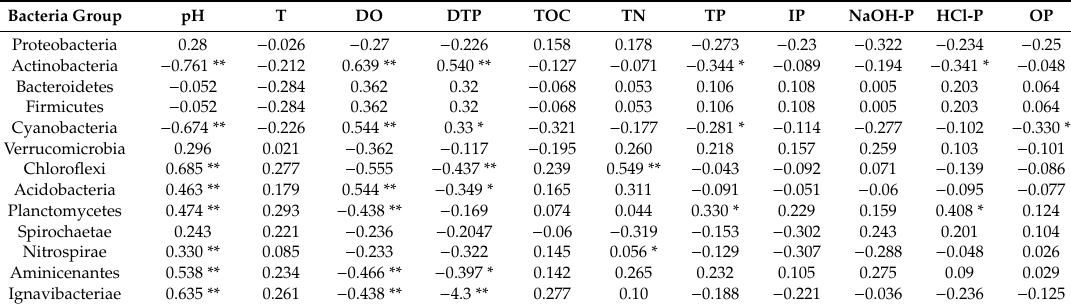
Table 2. Correlation coe ffi cients between bacteria groups and physico-chemical